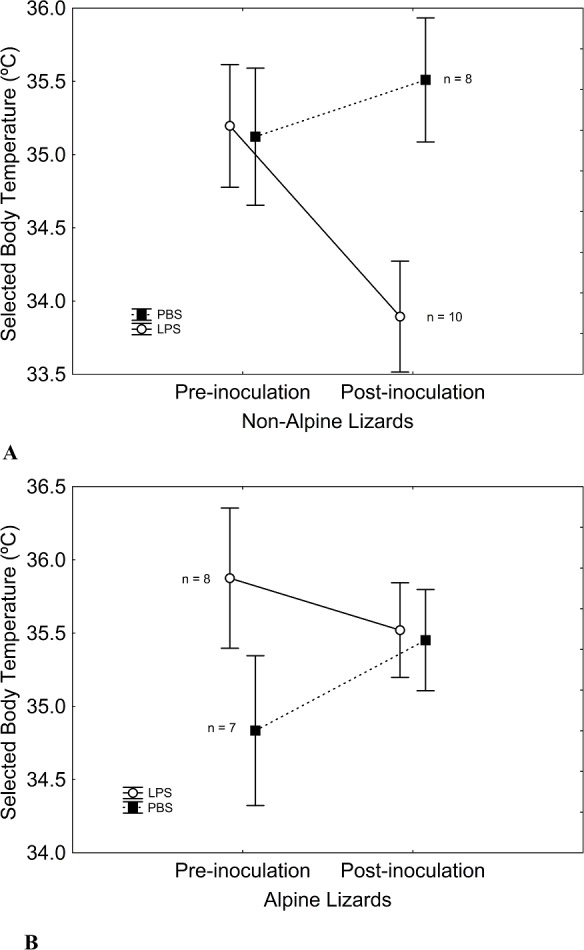
Lizard \documentclass[12pt]{minimal}
\usepackage{amsmath}
\usepackage{wasysym}
\usepackage{amsfonts}
\usepackage{amssymb}
\usepackage{amsbsy}
\usepackage{upgreek}
\usepackage{mathrsfs}
\setlength{\oddsidemargin}{-69pt}
\begin{document}
}{}${T}_{\mathrm{pref}}$\end{document}Tpref before and after inoculations for each elevation belt regarding treatment.All lizards showed similar preferred body-temperature \documentclass[12pt]{minimal}
\usepackage{amsmath}
\usepackage{wasysym}
\usepackage{amsfonts}
\usepackage{amssymb}
\usepackage{amsbsy}
\usepackage{upgreek}
\usepackage{mathrsfs}
\setlength{\oddsidemargin}{-69pt}
\begin{document}
}{}$({T}_{\mathrm{pref}})$\end{document}Tpref before inoculations. After inoculations, a trade-off between \documentclass[12pt]{minimal}
\usepackage{amsmath}
\usepackage{wasysym}
\usepackage{amsfonts}
\usepackage{amssymb}
\usepackage{amsbsy}
\usepackage{upgreek}
\usepackage{mathrsfs}
\setlength{\oddsidemargin}{-69pt}
\begin{document}
}{}${T}_{\mathrm{pref}}$\end{document}Tpref and immune system appeared in non-alpine lizards (Fig. 1A), since LPS-inoculated lizards showed lower \documentclass[12pt]{minimal}
\usepackage{amsmath}
\usepackage{wasysym}
\usepackage{amsfonts}
\usepackage{amssymb}
\usepackage{amsbsy}
\usepackage{upgreek}
\usepackage{mathrsfs}
\setlength{\oddsidemargin}{-69pt}
\begin{document}
}{}${T}_{\mathrm{pref}}$\end{document}Tpref than did PBS-inoculated lizards. Nevertheless, this trade-off did not affect alpine lizards (Fig. 1B), which selected similar temperatures after inoculations regardless of the substance inoculated. Vertical bars represent standard errors.